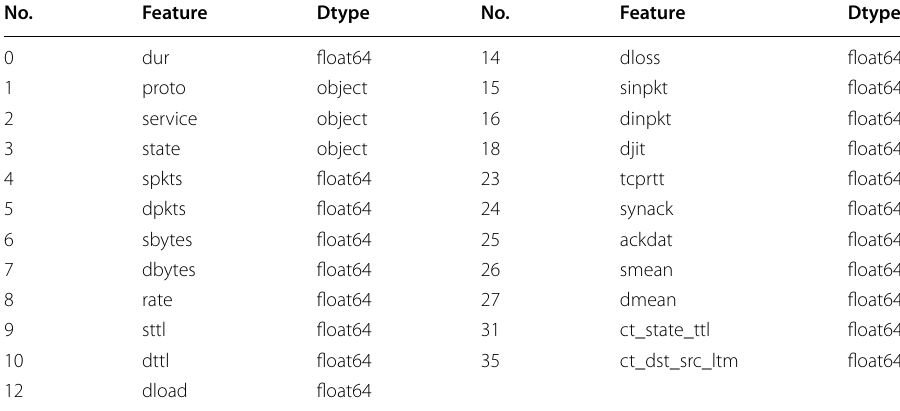
Table 6 Selected features by IGRF‑RFE